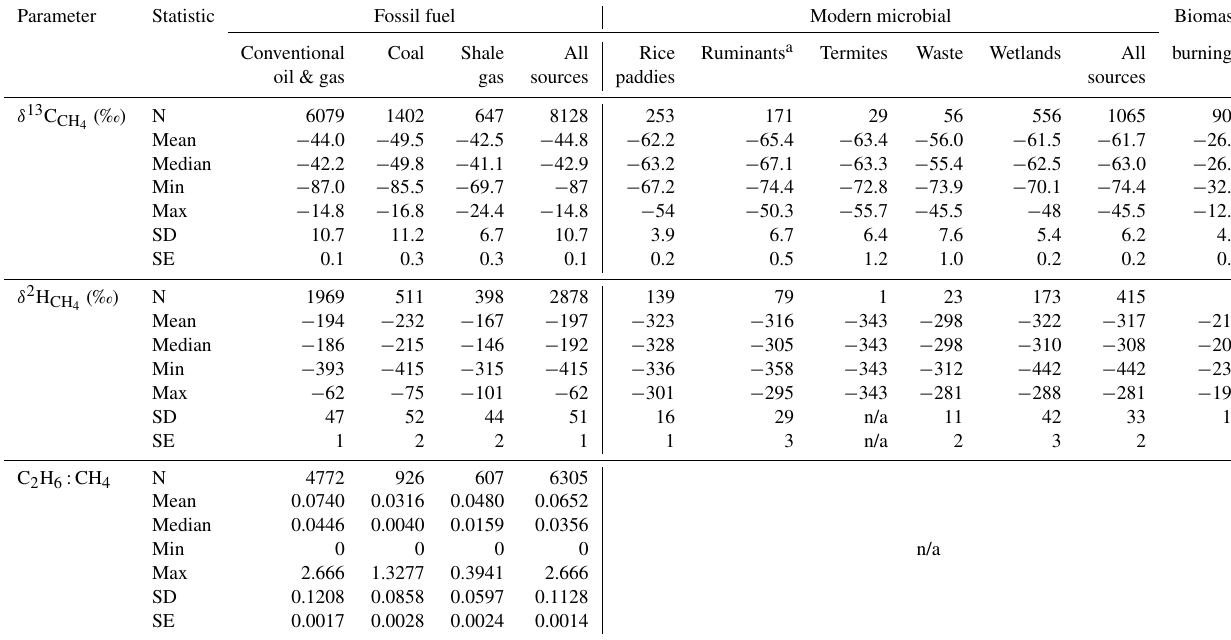
Table 5. Database summary statistics (unweighted) by gas type and parameter. Parameter